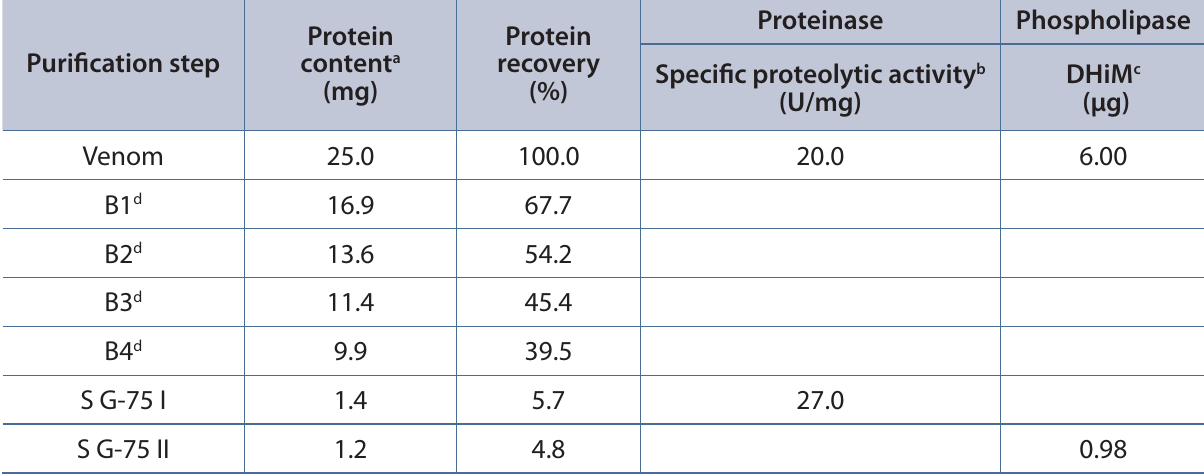
Table 1. Purification of proteinase and phospholipase A of ATPS and gel filtration